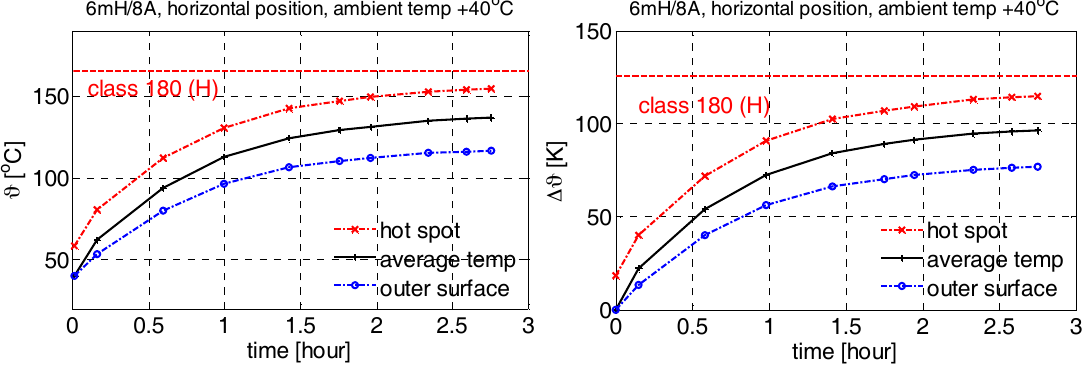
Figure 12. Temperature rise in the filter under full load operation ( left ); temperature difference ( right ).